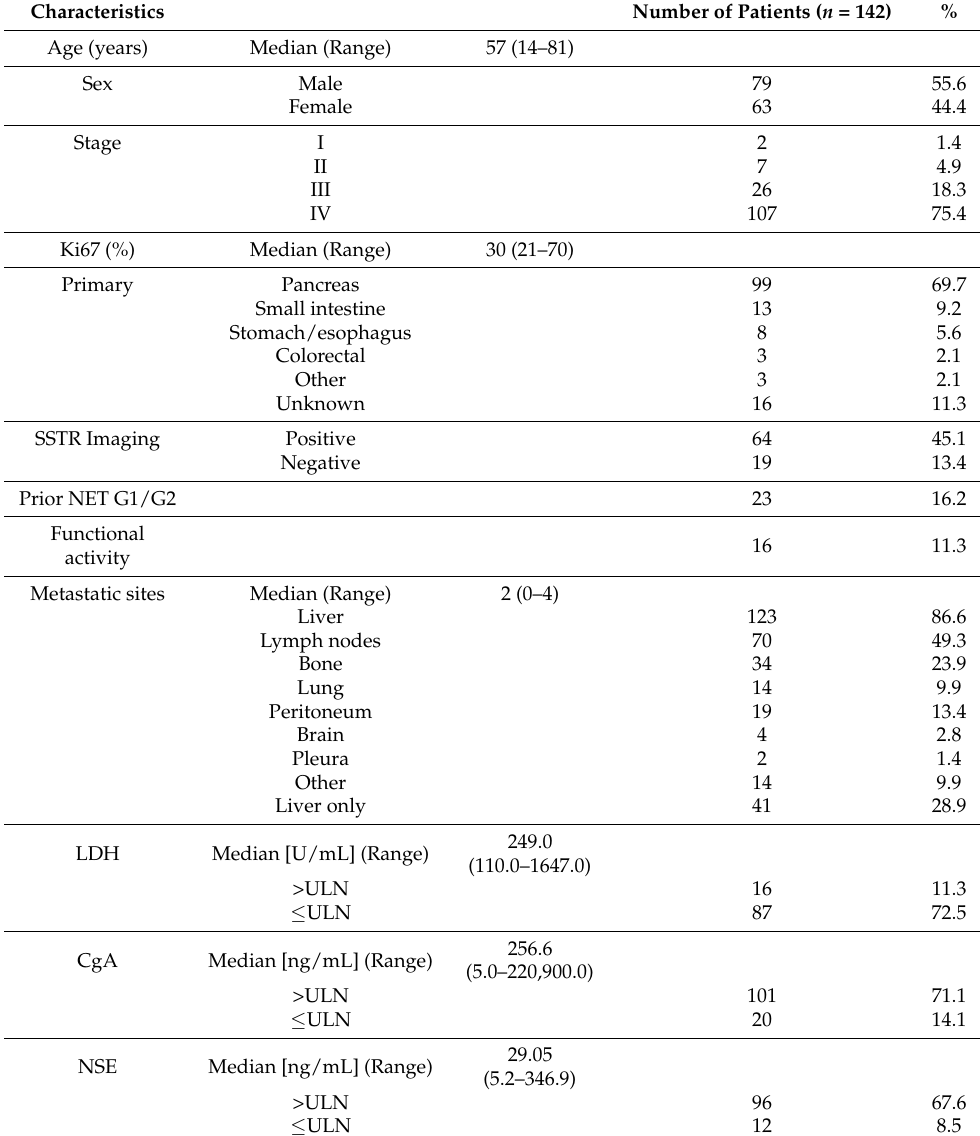
Table 1. Patient